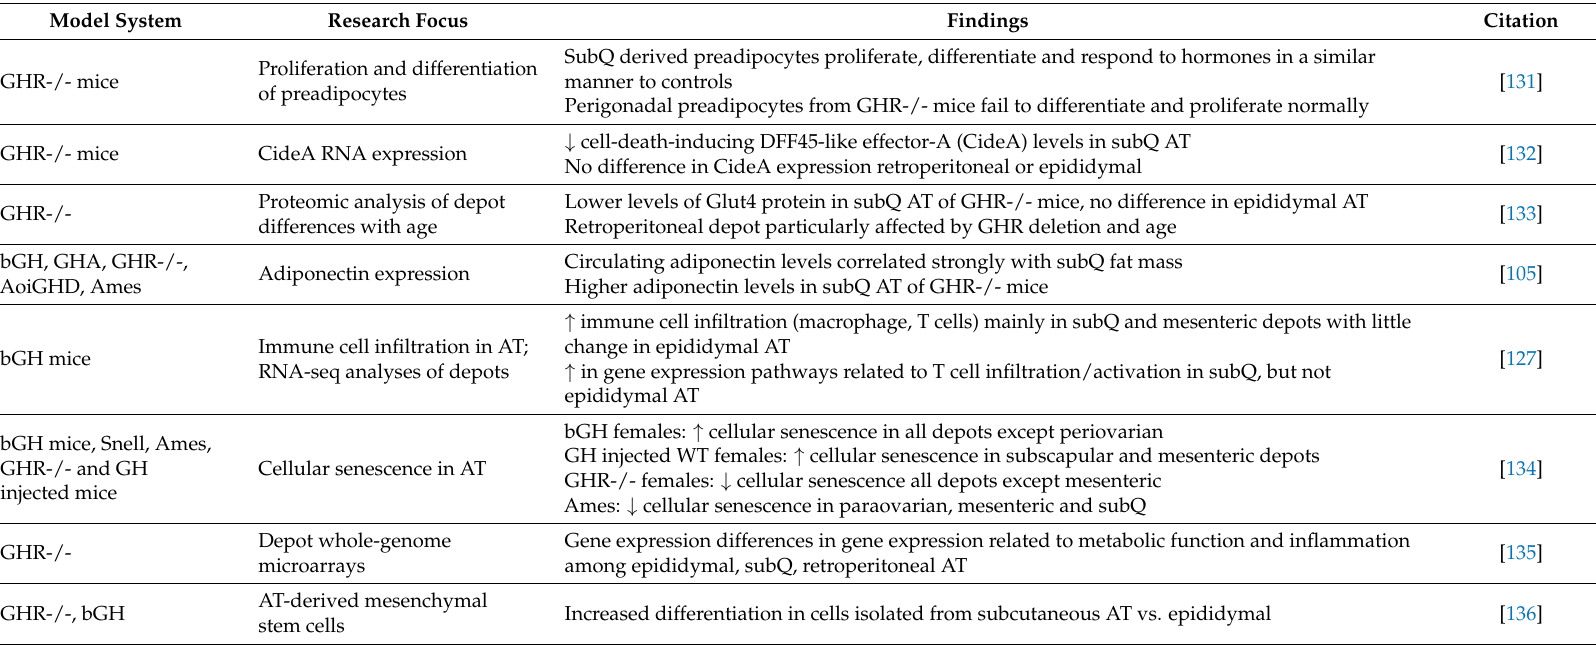
Table 2. Evidence for depot-specific differences in mice due to extremes in GH action. AoiGHD, adult onset-isolated GHD